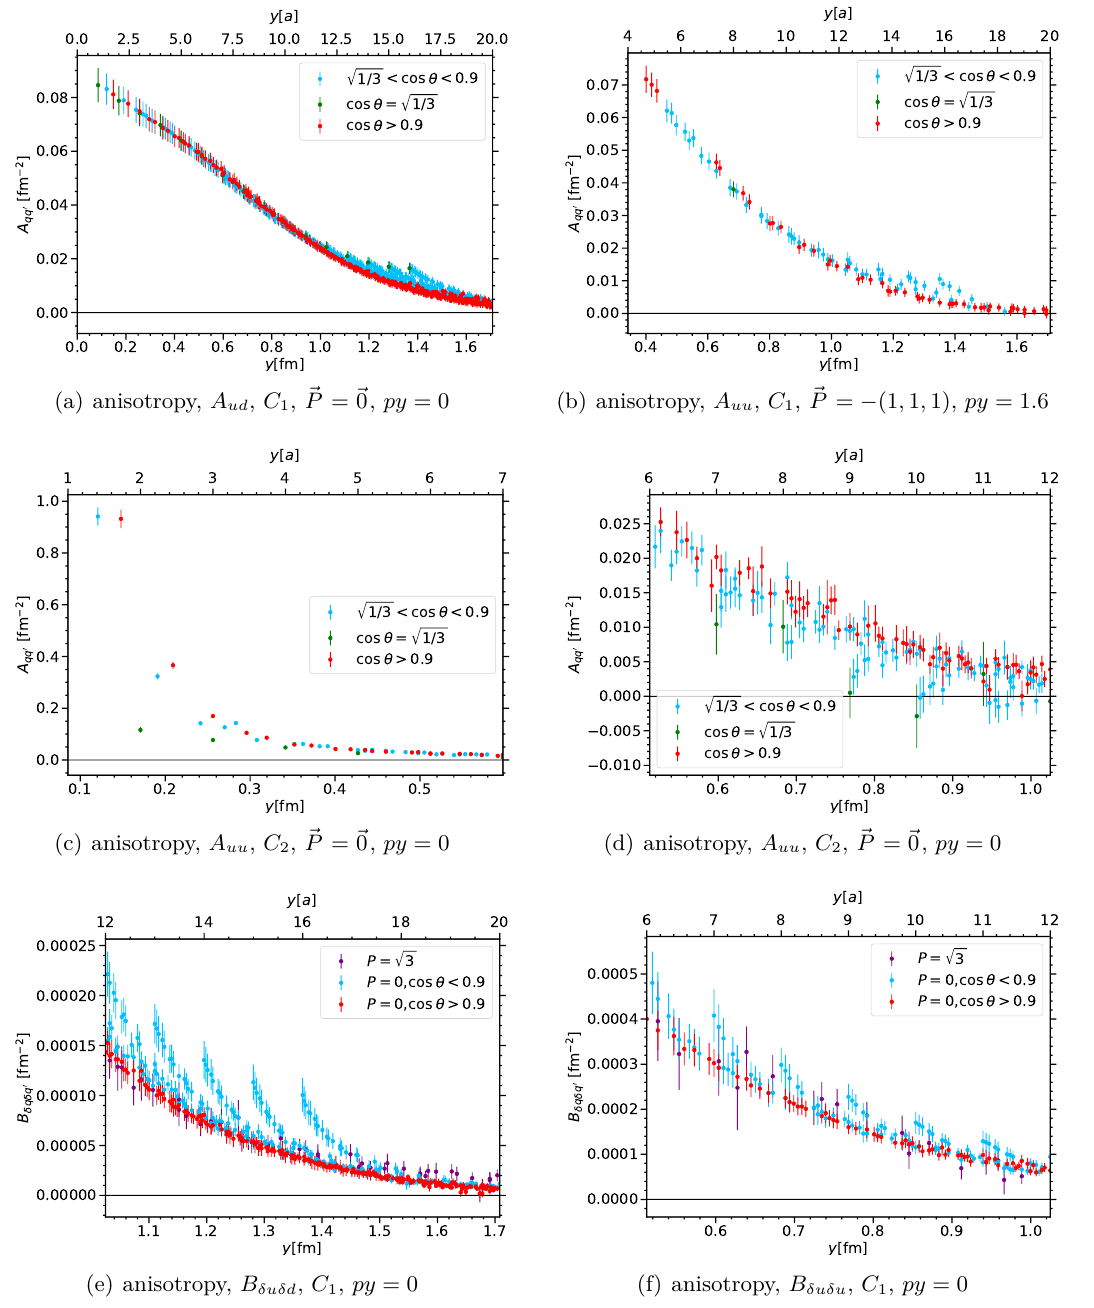
Figure 8 . Visualization of anisotropies in the data of twist-two functions. We separate the data points w.r.t. the angle between ~y and the nearest diagonal in the same manner as in figure 7. This figure shows the corresponding results for the C contributions to A (a) and A (b), as well 1 ud uu as the C contribution to A for small y (c) and large y (d). In panel (b) we plot the data for 2 uu non-zero momentum and py = 1 . 6 , whereas in the remaining plots ~P = ~ 0 . In panels (e) and (f) we show the data for B and B , respectively, where we distinguish only between cos θ < 0 . 9 δuδd δuδd √ and cos θ > 0 . 9 . This is compared to the data for P = 3 at py = 0